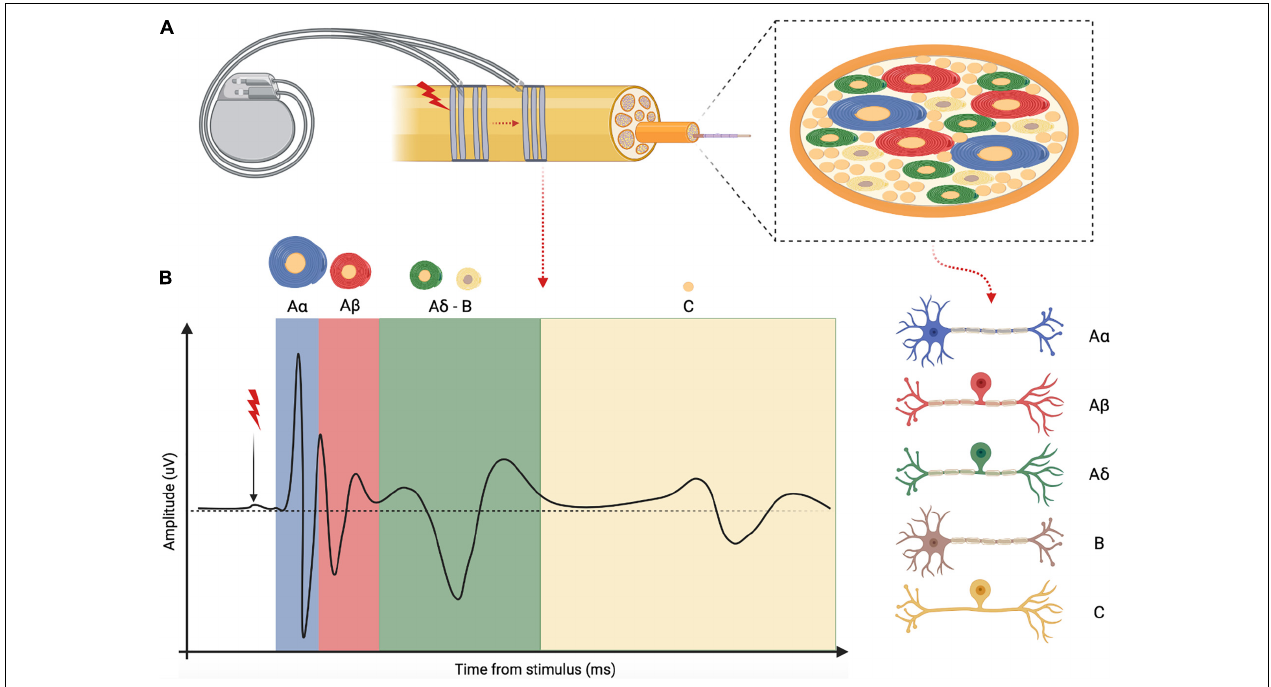
FIGURE 7 | Schematic representation and explanation of the electrically evoked compound action potential (eCAP). (A) Example of a VNS device that electrically stimulate the vagus nerve at one site while recording evoked activity at another site. Inset: vagal fascicle containing different fiber types distinguished by myelination